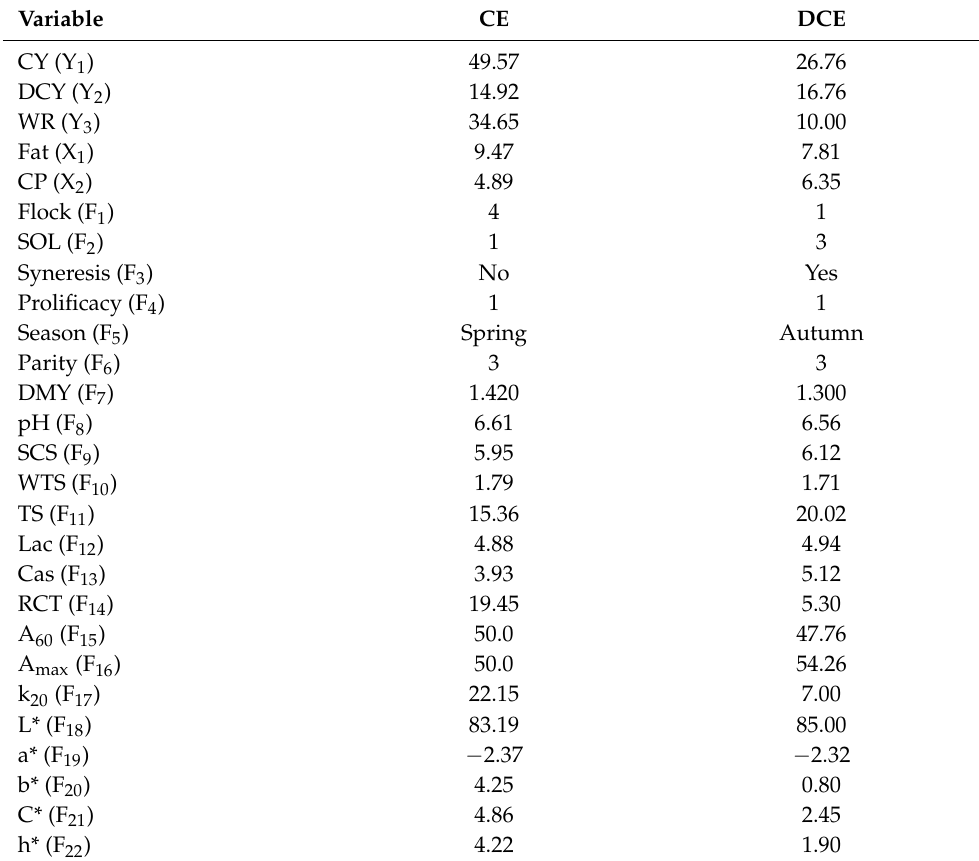
Table 3. Traits that optimize coagulation efficiency in Manchega ewe milk ( n = 967).